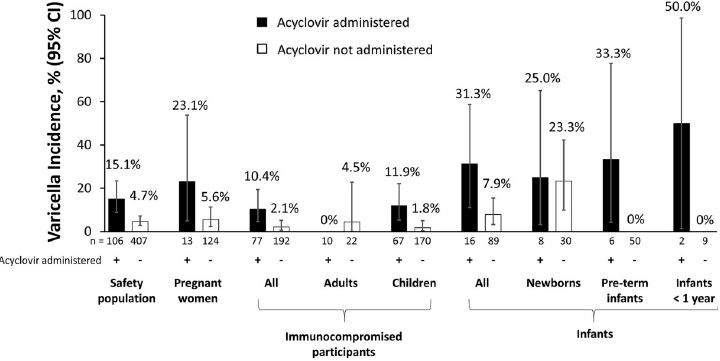
Fig 4. Incidence of varicella by absence or presence of concomitant antiviral therapy. CI confidence